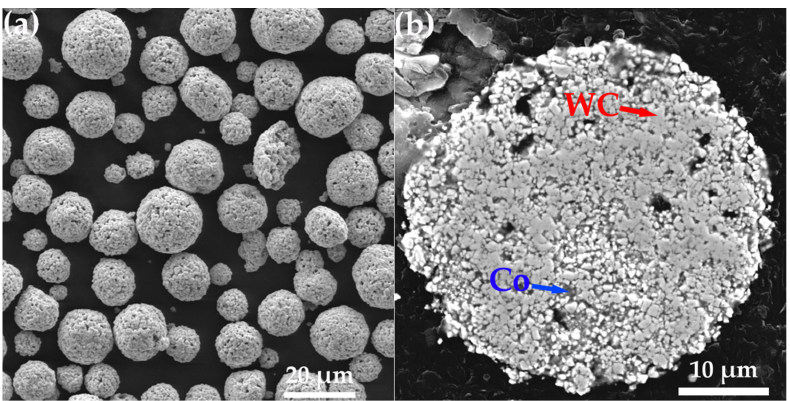
Figure 1. The morphologies of WC-17Co powder ( a ) surface, 2000×, ( b ) cross-section, 5000×.